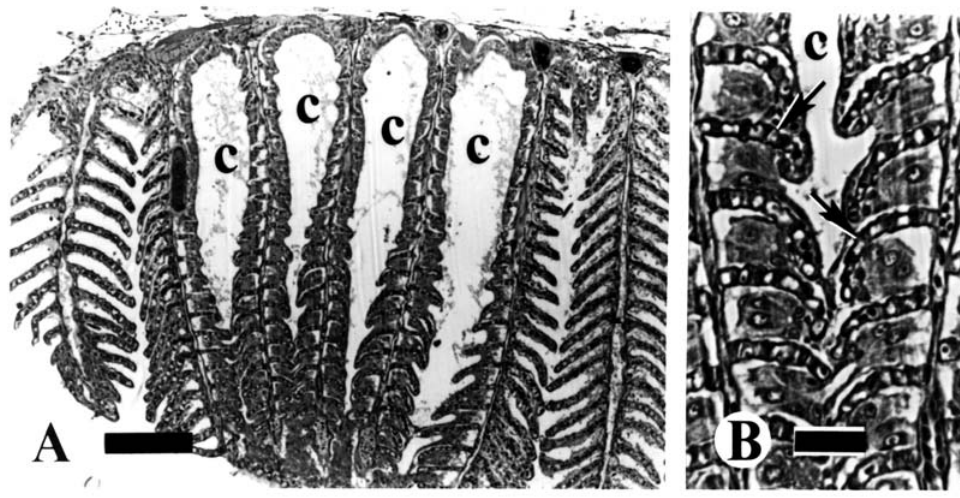
Fig. 20. Light micrographs through gill gland of mature male Bryconadenos tanaothoros , SL 36.6 mm (USNM 352061). A, entire gill gland showing chambers (c) containing some stained material; unmodified gills are seen at the extreme left and right; bar, 100 µ m. B, Enlargement of same specimen showing one chamber (c) with tall columnar cells in between reduced secondary lamellae (arrows); bar, 20 µ